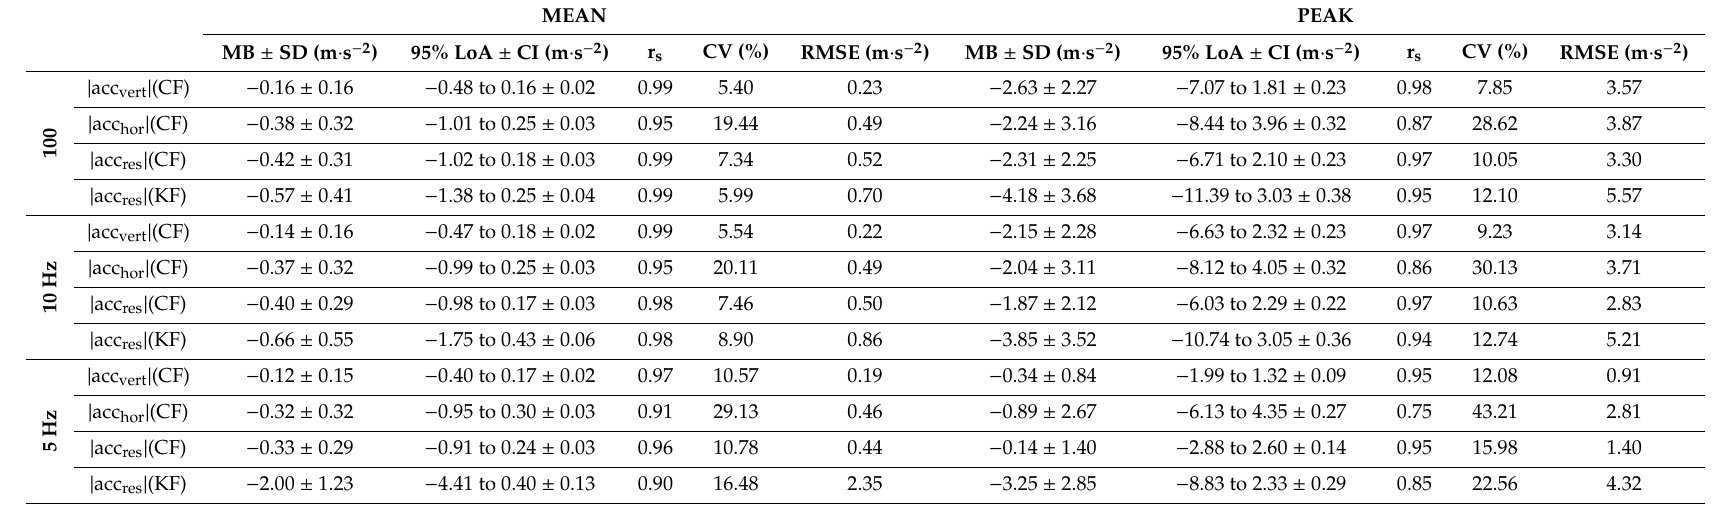
Table 1. Analysis of agreement between CF or KF data and MA system data over all trials ( n = 1093). Outcomes for mean and peak values are presented at each temporal resolution. Results refer to | acc res | , | acc hor | and | acc vert | . MB, mean bias; SD, standard deviation; 95% LoA, 95% limits of agreement; CI, confidence